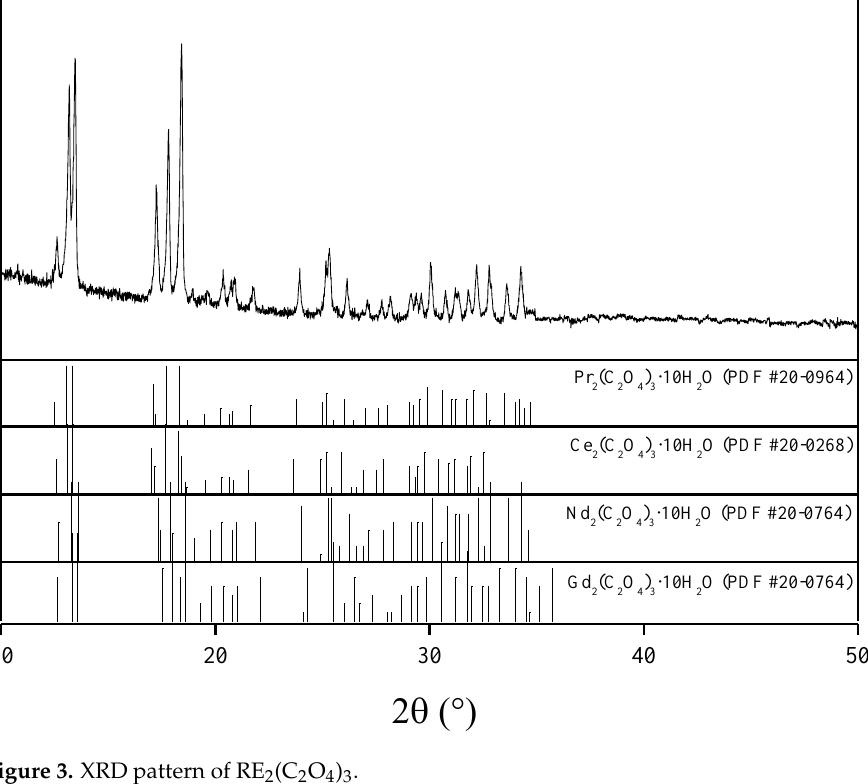
Figure 4. SEM images of RE 2 (C 2 O 4 ) 3 . 3.2. Double Sulfates Precipitation–Alkali Conversion Method 3.2.1. Double sulfates precipitation of REEs The effect of the reaction temperature and Na 2 SO 4 amount (actual amount (mol)/the- oretical amount (mol)) on the precipitation of REEs over 1 h and the results are displayed in Figure 5.